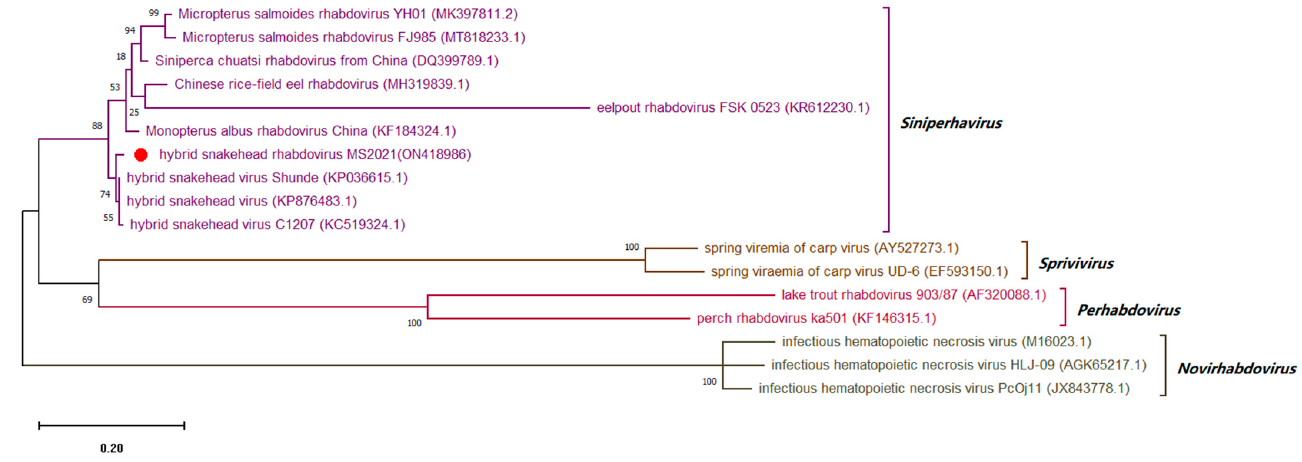
Figure 8. Maximum-likelihood tree of the glycoprotein (G protein) gene sequence of HSHRV-MS2021. HSHRV-MS2021 is designated by the red dot. GenBank accession numbers are shown in brackets. The evolutionary history was inferred by using the Maximum Likelihood method and General Time Reversible model. The tree with the highest log likelihood ( − 14131.39) is shown. The percentage of trees in which the associated taxa are clustered together is shown next to the branches.